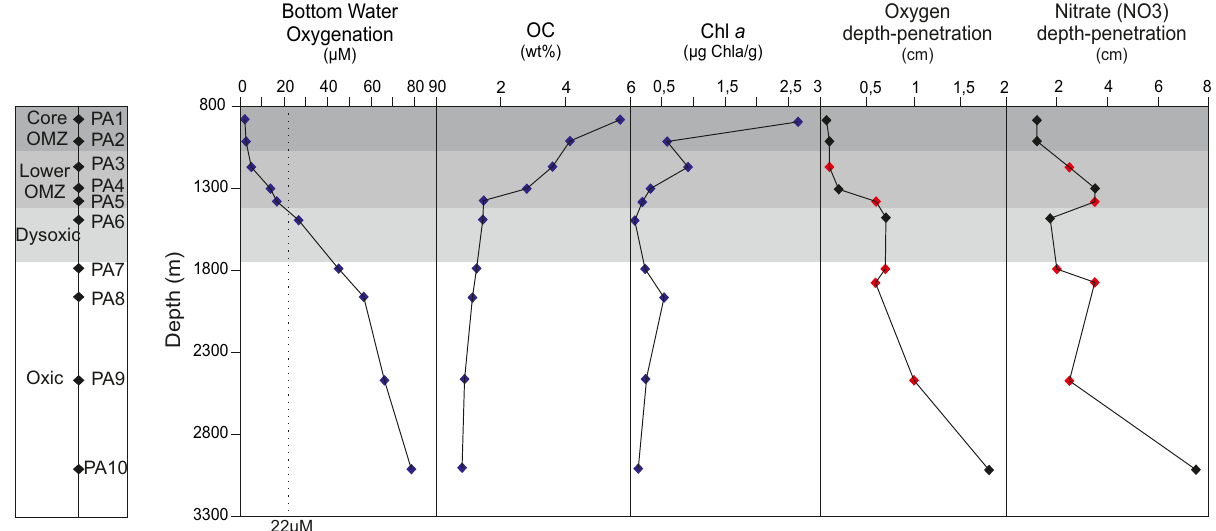
Fig. 2. Environmental parameters: bottom water oxygenation, organic carbon (OC; 0–1cm), chlorophyll a (Chl a , 0–1cm), oxygen and nitrate penetration depths. In red: the results from this study; in blue: the results published in Koho et al. (2013); in black: the results published in Kraal et al. (2013). The dashed line at 22µM corresponds to the definition of the OMZ according to Levin et al.